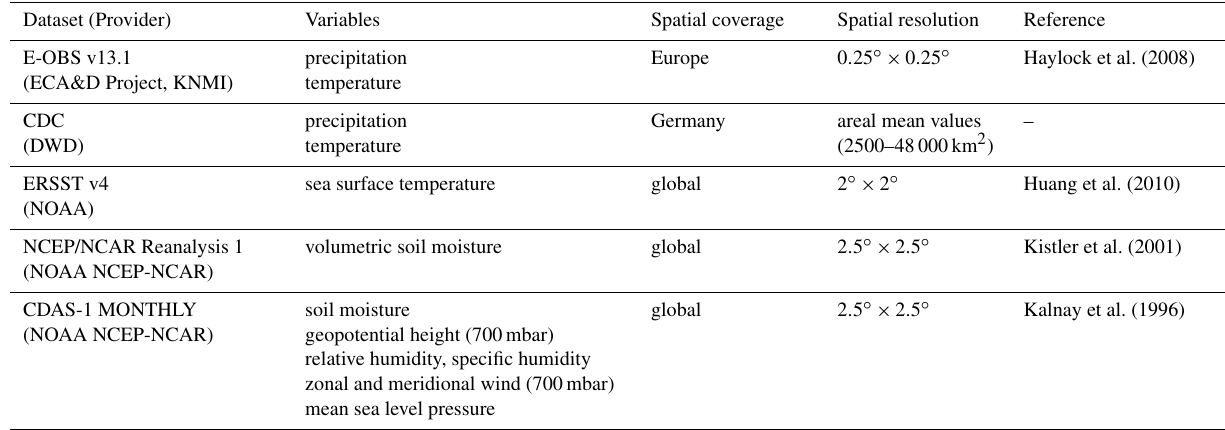
Table 2. Climate and oceanic data sources used in the statistical forecast